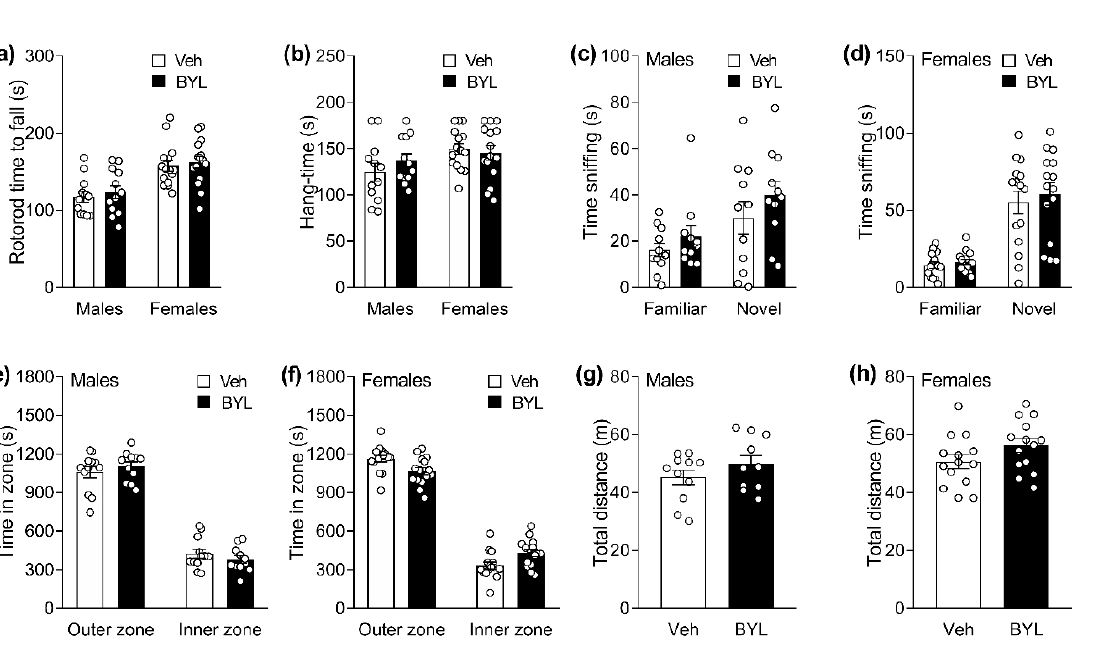
Figure 6. Rotarod ( a ) and hang time performance ( b ), novel and familiar object sniffing time (novel object test, c , d ), time spent in inner and outer zone ( e , f ) and total movement distance ( g , h ) during open field test for middle-aged male and female mice after receiving a control- (Veh; vehicle) or BYL719 (BYL)-containing diet. Data are presented as mean ± SE, statistical analysis was by t -test ( a , b , g , h ) or two-way ANOVA with Sidak post-hoc ( c – f ).